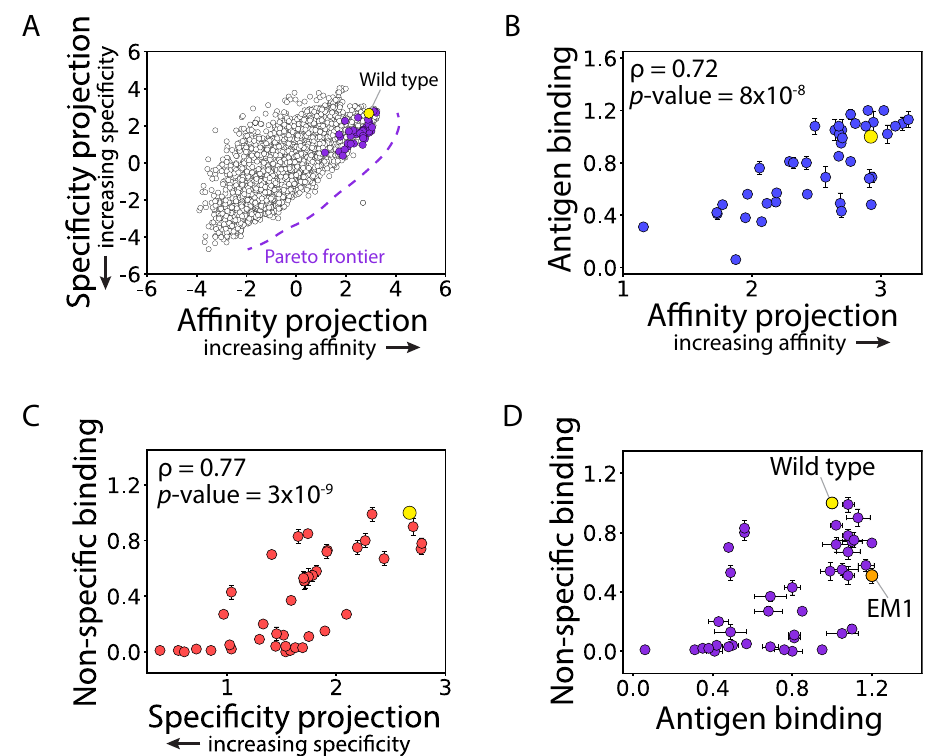
Fig. 4 Model predictions and experimental evaluation of Pareto optimal af fi nities and speci fi cities for emibetuzumab mutants in the sorted antibody libraries. A Visualization of the predicted Pareto frontier for the 4000 library variants using the LDA models reported in Fig. 3. Antibody mutants located along the Pareto frontier are predicted to display co-optimized af fi nity and speci fi city, as increases in either property requires decreases in the other one. B , C Antibody mutants (41 antibodies) at or near the predicted Pareto frontier were generated as soluble IgGs, and their ( A ) antigen binding (1 nM HGFR) and ( B ) non-speci fi c binding (0.1 mg/mL ovalbumin) were evaluated and plotted relative to the continuous model predictions. D Comparison of the experimentally measured values of antigen and non-speci fi c binding for the 41 IgGs reported in parts ( B ) and ( C ). In ( B – D ), the experimental measurements are averages of three independent repeats, and the error bars are standard deviations. Independent two-sided t -tests were performed to determine signi fi